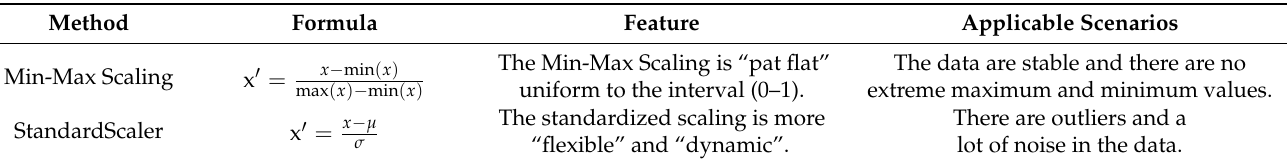
Table 4. Summary of dimensionless methods.